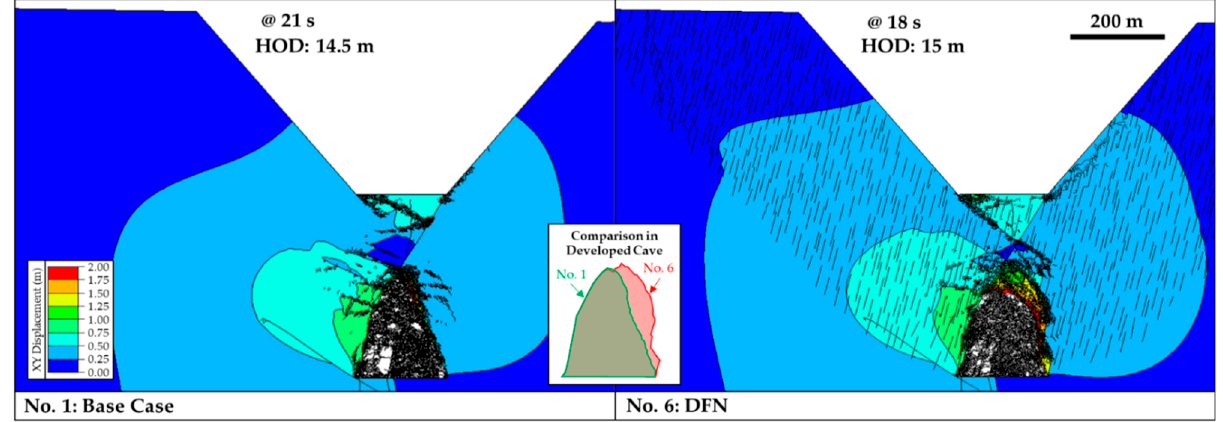
Figure 15. FDEM model results for models No. 1 and No. 6 with similar displacement in left pit wall. Maximum XY displacement contours.